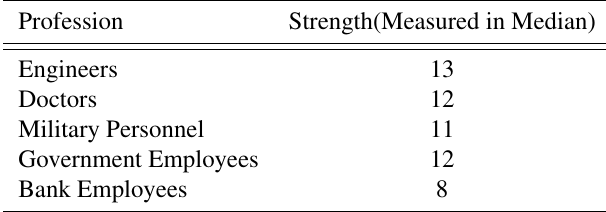
Table 2. Mean Password Strength of Various